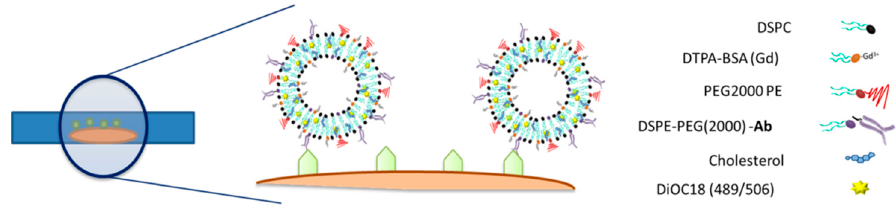
Figure 5. Molecular imaging strategy for the quantification of myelin in organotypic cultures. Antimyelin stealth liposomes doped with gadolinium and Dioc18 were incubated with the cultured tissue for later detection with imaging techniques (see Section 2 for the full names of the abbreviated chemicals in the figure).